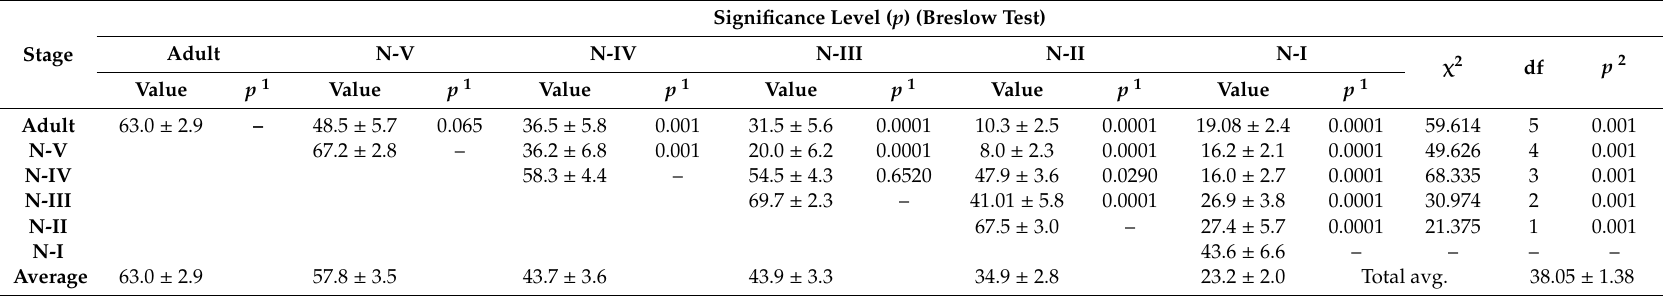
Table A4. Aggressiveness of Nabis pseudoferus cannibalism on di ff erent stage class, measured as survival time (hours) ( ± SE) when caged singly with other conspecifics for 72 h under laboratory conditions (25 ± 1 ◦ C and 60–80% RH) and without prey.